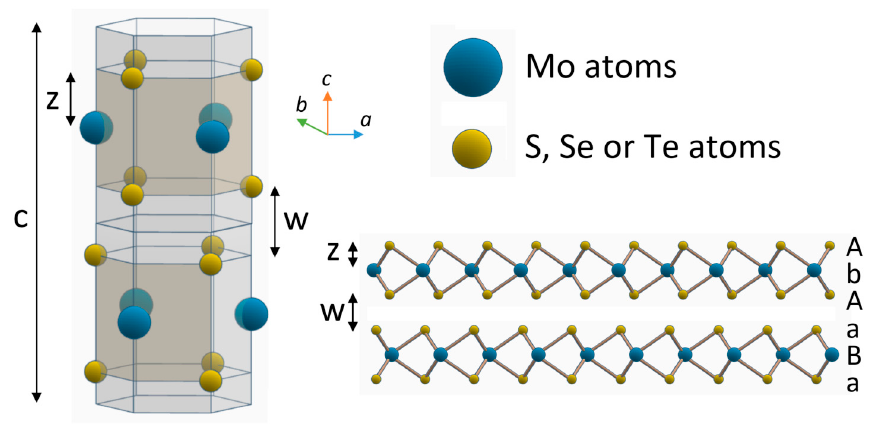
Figure 4. Crystal structure of 2H structured Mo dichalcogenides, with |AbA BaB| stacking sequence, where capital and lower letters refer to chalcogen and metal atoms, respectively. Table 1. Cell and structural parameters and measured bandgaps of 2H polytype Mo dichalcogenides [18–20].